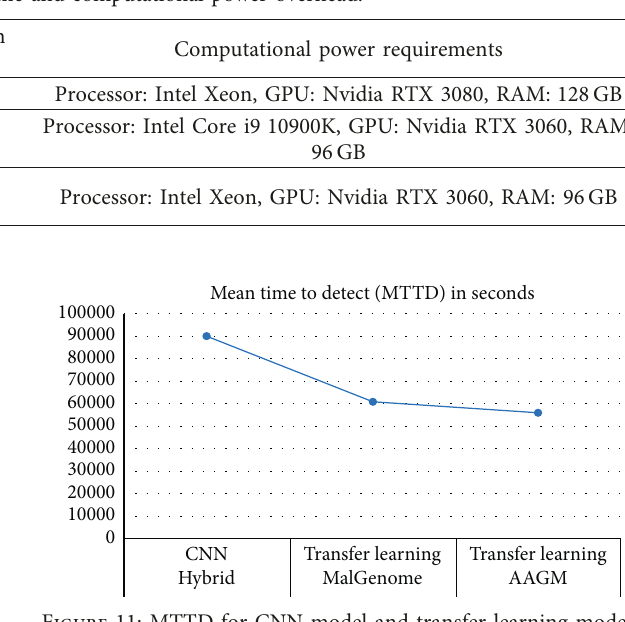
Table 7: Comparison of training time and computational power overhead.